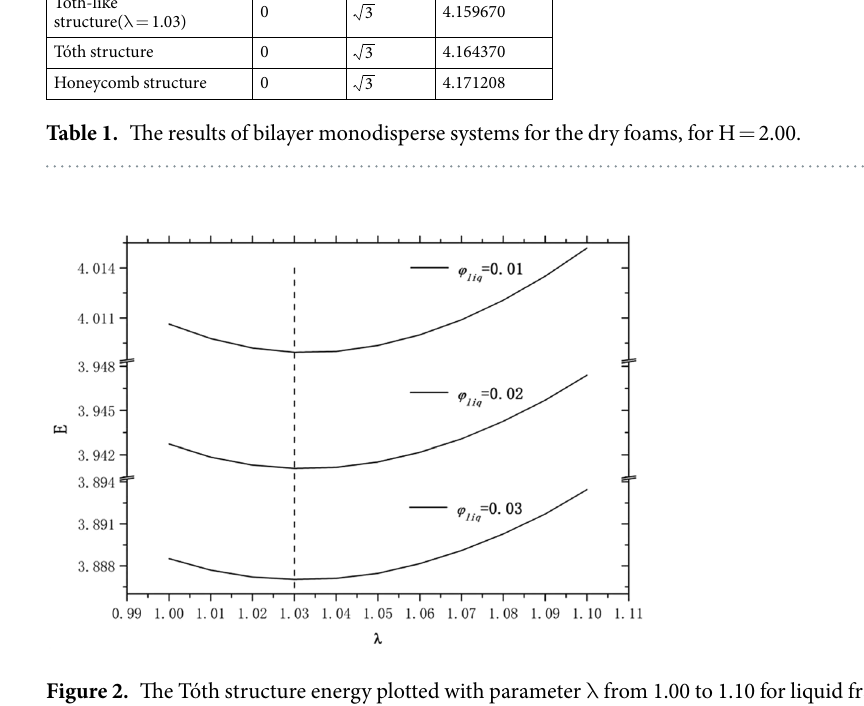
Figure 2. The Tóth structure energy plotted with parameter λ from 1.00 to 1.10 for liquid fractions 0.01, 0.02 and 0.03. The Tóth structure attains its minimum energy for each ϕ liq when λ ≈